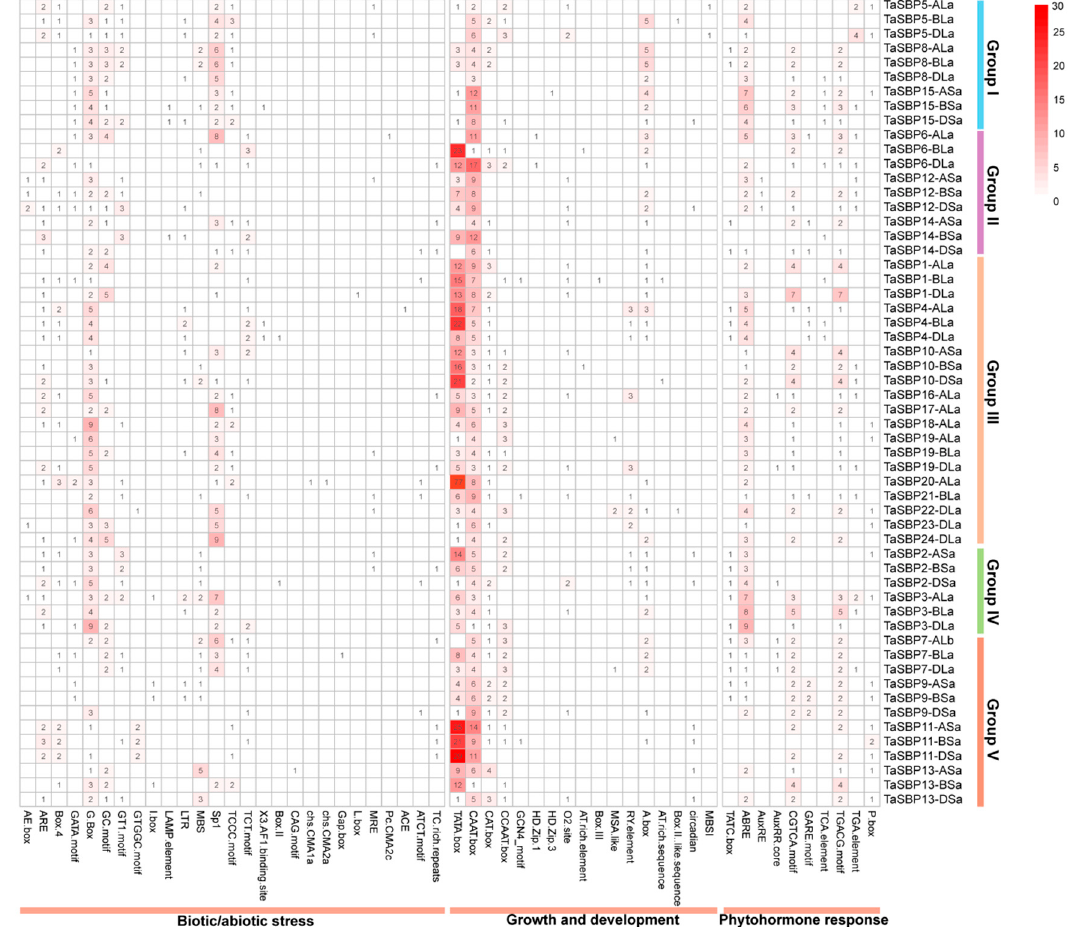
Figure 7. Cis -acting elements in the promoters of hexaploid wheat SBP genes. The different shades of red color represent the number of cis -acting red color represent the number of cis -acting elements.